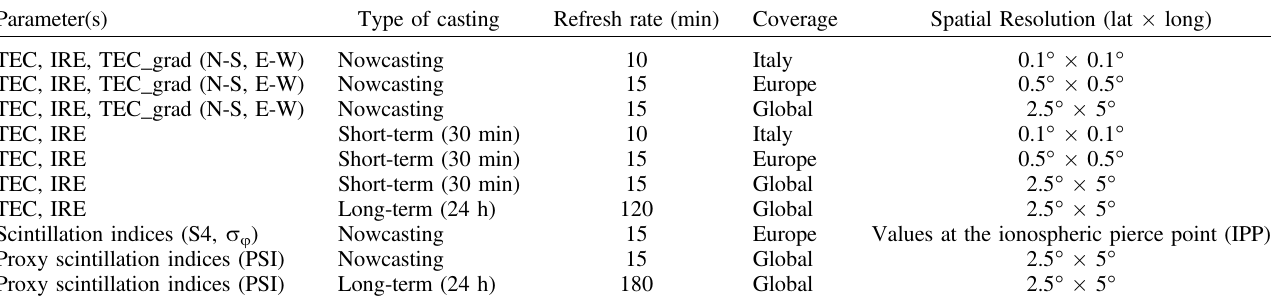
Table 3. List of the RPF 2 products related to the ionospheric TEC and scintillation along with the casting type, the refresh time, the coverage and the spatial resolution.